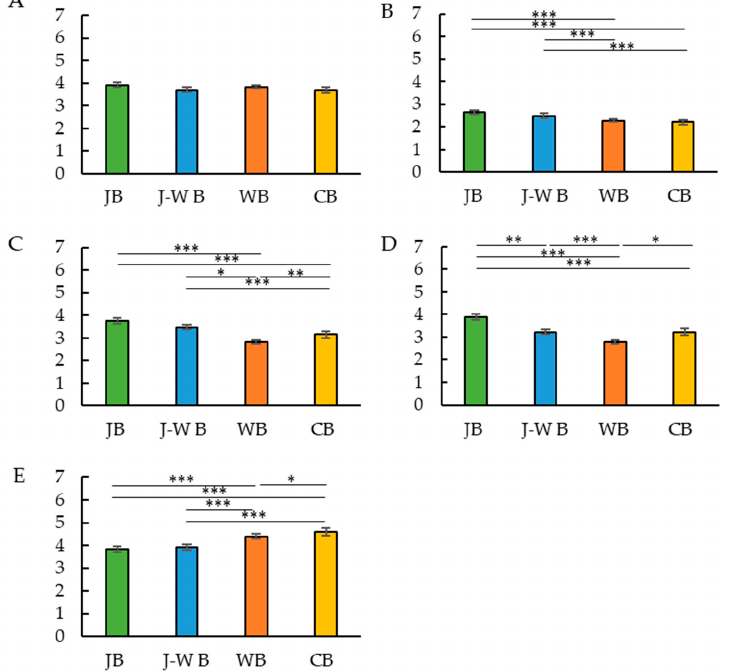
Figure 1. Breakfast style and usual protein source intake score. Breakfast style and meat score ( A ). Breakfast style and fish score ( B ). Breakfast style and eggs score ( C ). Breakfast style and beans score ( D ). Breakfast style and dairy products score ( E ). * p < 0.05, ** p < 0.005, *** p < 0.001 (Dunn’s test).